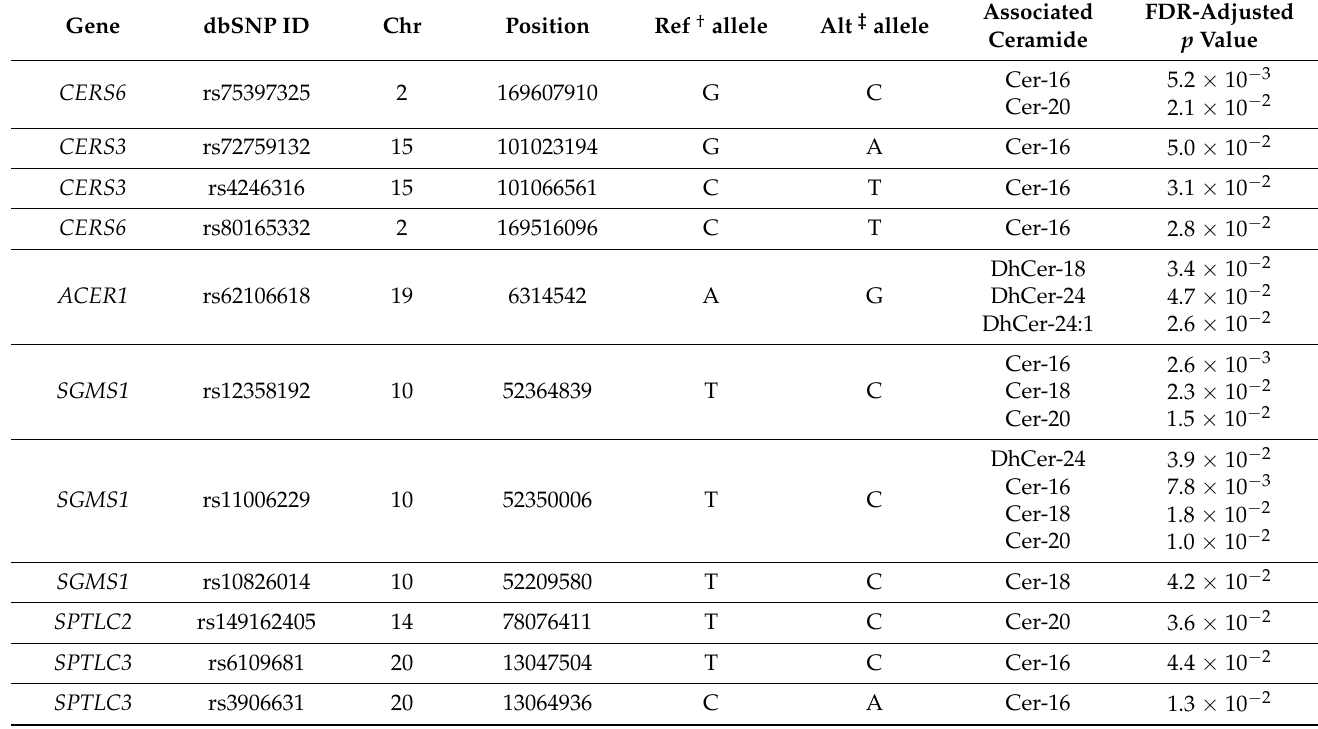
Table 3. SNPs associated with elevated plasma ceramides.